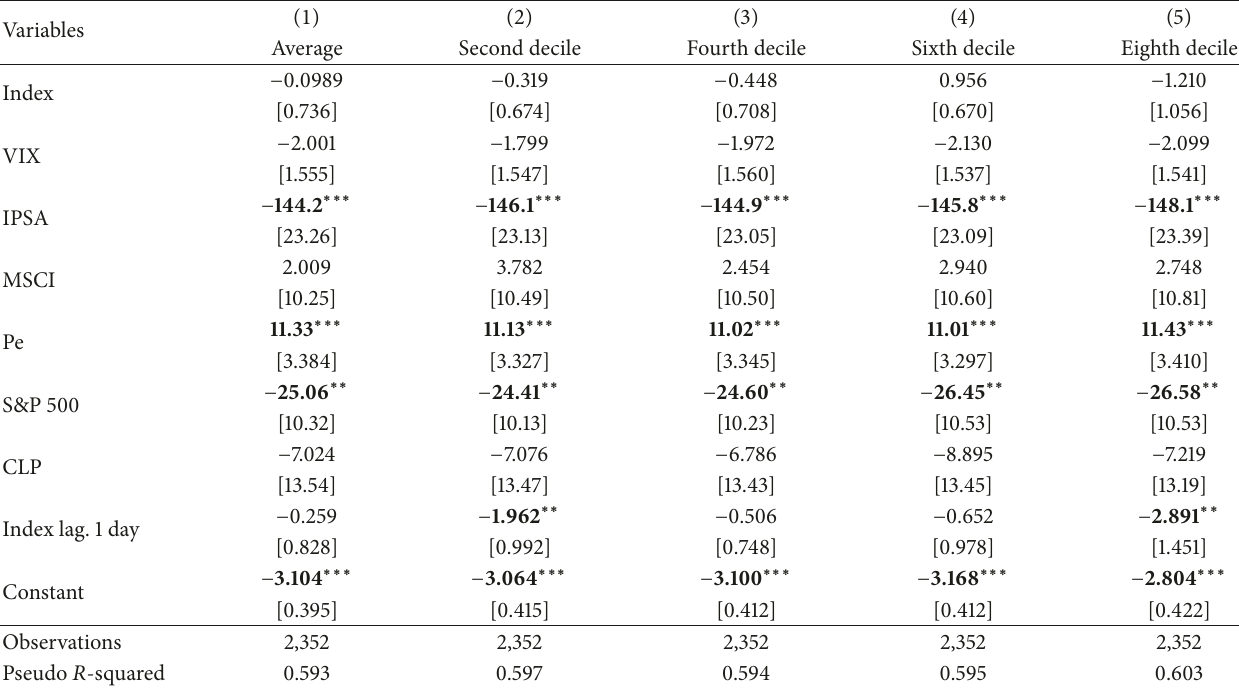
Table 6: Probit model, IPSA negative shocks. This table summarizes the results of the following probit model: Pr (𝐼 𝑡 = 1) = Φ(𝛼 + 𝜆 1 ∗ 𝑦 𝑡 + 𝜆 ∗𝑦 +𝛽∗𝑋 +𝑚 +𝑁 ) . The probit is defined over 𝐼 2 𝑡−1 𝑡 𝑡 𝑡 𝑡 which is 1 when the daily losses on the IPSA surpass two standard deviations, and it is 0 otherwise. The independent variables are the index 𝑦 𝑡 and a set of variables 𝑋 𝑡 that include the returns or growth rate of variables such as IPSA, VIX, Pe, CLP, S&P 500, and MSCI. 𝑚 𝑡 and 𝑁 𝑡 are month and year fixed effects to control for seasonality and variation associated with any specific year. Column (1) uses the average transaction as a threshold. Columns (2) to (5) use the second, fourth, sixth, and eighth deciles as